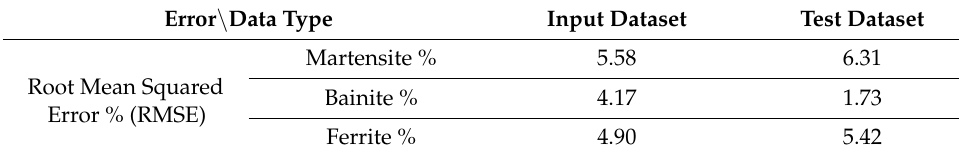
Table 6. Loss Functions for Step 2 (RMSE).